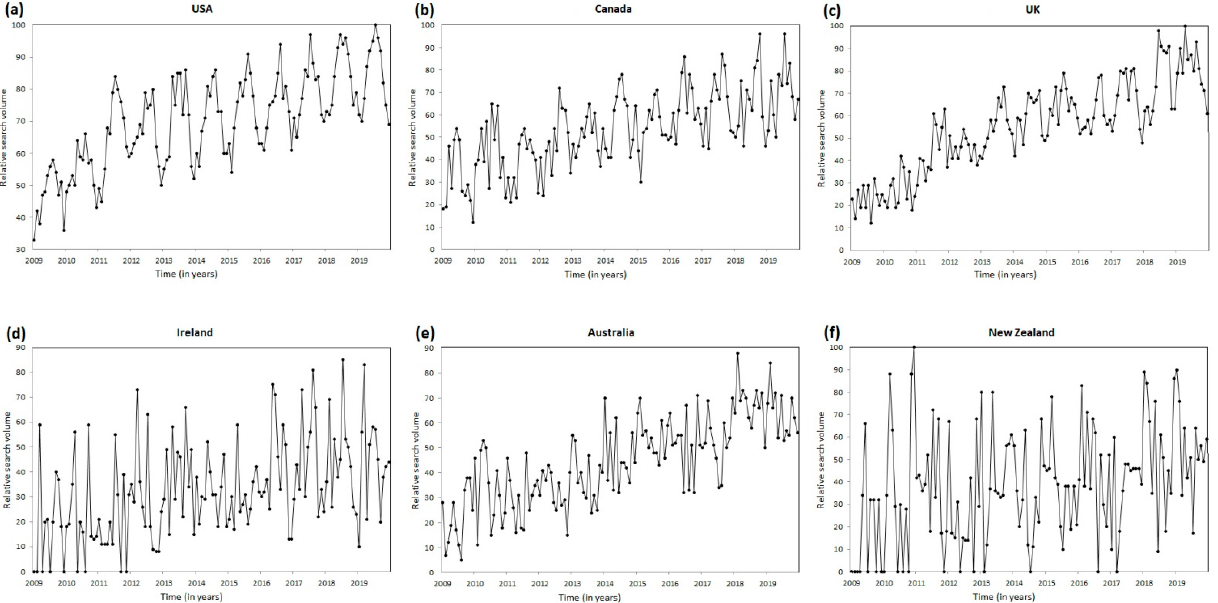
Figure 4. Time series plots for Google Trends search volume data for “heel pain” from January 2009 to December 2019 in ( a ) the USA, ( b ) Canada, ( c ) the U.K., ( d ) Ireland, ( e ) Australia, and ( f ) New Zealand.